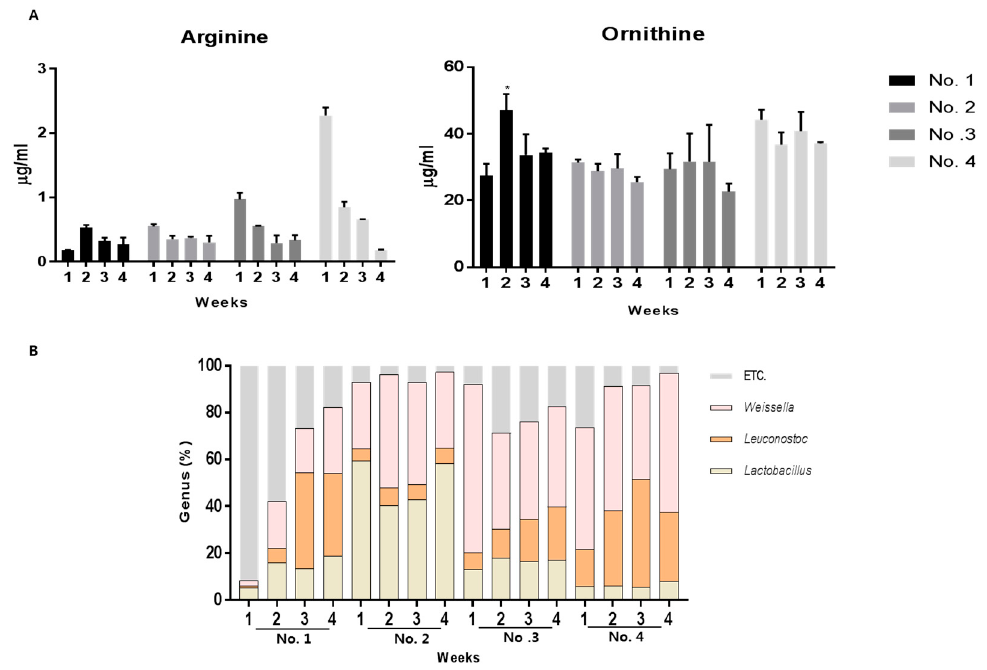
Figure 5. Arginine catabolism during kimchi fermentation. ( A ) Quantification of arginine and ornithine production in kimchi; ( B ) comparison of bacterial communities among the commercial kimchi samples. All kimchi samples were purchased from a local